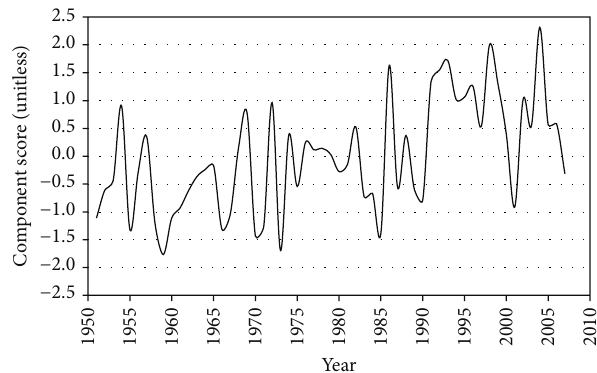
Figure 5: Yearly scores for single component explaining 80.9% of the variance in seven indices of extreme precipitation. Year component scores (standardized, mean of 0 and standard deviation of 1) for the single component explaining 80.9% of the variance in seven indices of extreme precipitation. The upward trend suggests that extreme precipitation events, irrespective of how they are defined, are increasing in Iran.